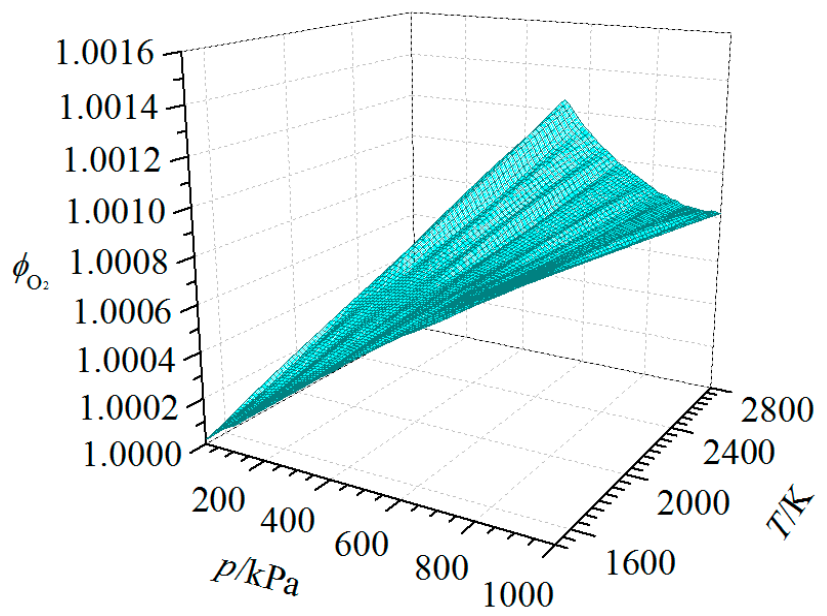
Figure 5. Fugacity coefficient of O 2 .